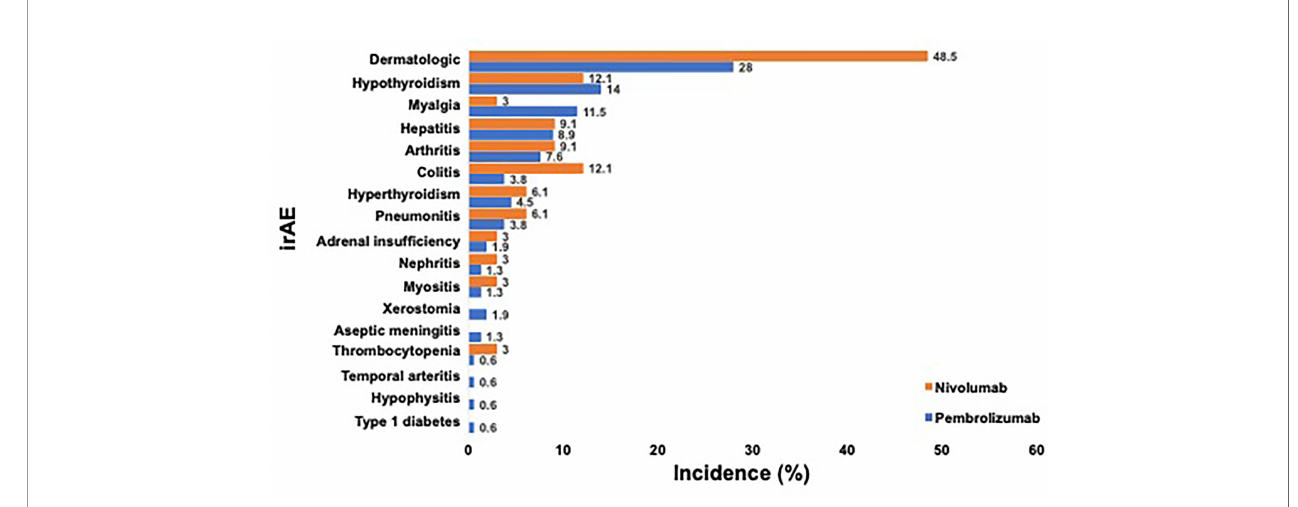
FIGURE 1 | Incidence of Any-grade irAE Occurring in at least One PD-1 Treated Advanced Melanoma Patient. a. Legend: Incidence of any-grade irAE that occurred in ≥ 1 patient after anti-PD-1 therapy for advanced melanoma is shown. Patients who received pembrolizumab (blue) and nivolumab (orange) are depicted separately. Incidence of each irAE is listed on the right.